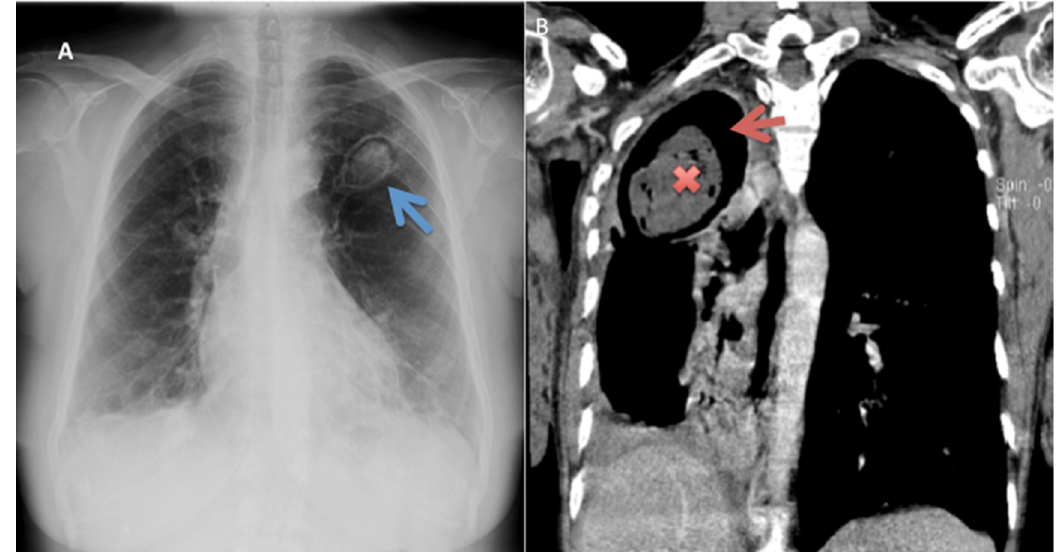
Figure 3. A chest X-ray of a 56-year-old woman with previously treated pulmonary tuberculosis (PTB) showing left apical thick-walled cavity with a well-circumscribed fungal ball (blue arrow) ( A ). A chest computed tomography of a 45-year old man with underlying diabetes and previously treated for PTB showing a fungal ball ( × ) and an air-crescent sign (red arrow), typical of chronic cavitary pulmonary aspergillosis ( B ). Images courtesy of Dr. Felix Bongomin.